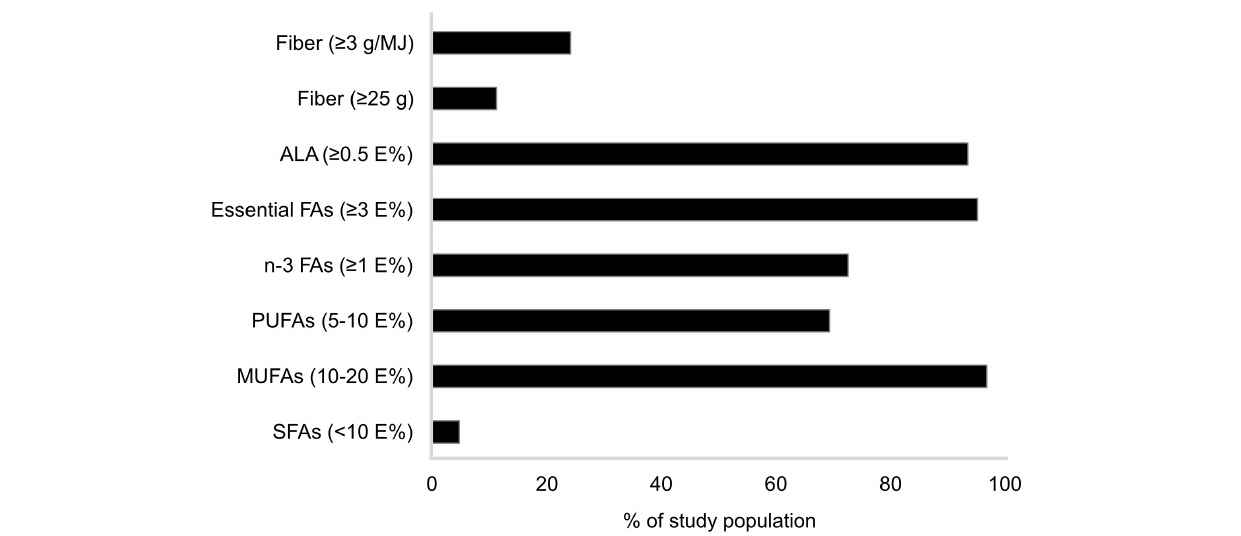
FIGURE 2 | Percentage of study population 1 ( n = 62) reporting a fatty acid and fiber intake corresponding to recommendations. 2 n-3 FA was calculated as the sum of alpha linolenic acid, eicosapentaenoic acid, docosahexaenoic acid, and docosapentaenoic acid. Essential FA was calculated as the sum of alpha linolenic acid and linoleic acid. 1 Patients with rheumatoid arthritis residing in southwestern Sweden. 2 Nordic Council of Ministers (31). Nordic Nutrition Recommendations 2012: Integrating nutrition and physical activity [Internet]. Copenhagen: Nordisk Ministerråd; [cited 2021 1 November]. Available from http://urn.kb.se/resolve?urn=urn:nbn:se:norden:org:diva-2561. ALA, alpha linolenic acid; E%, energy percent; FA, fatty acids; MUFA, monounsaturated fatty acids; PUFA, polyunsaturated fatty acids; SFA, saturated fatty